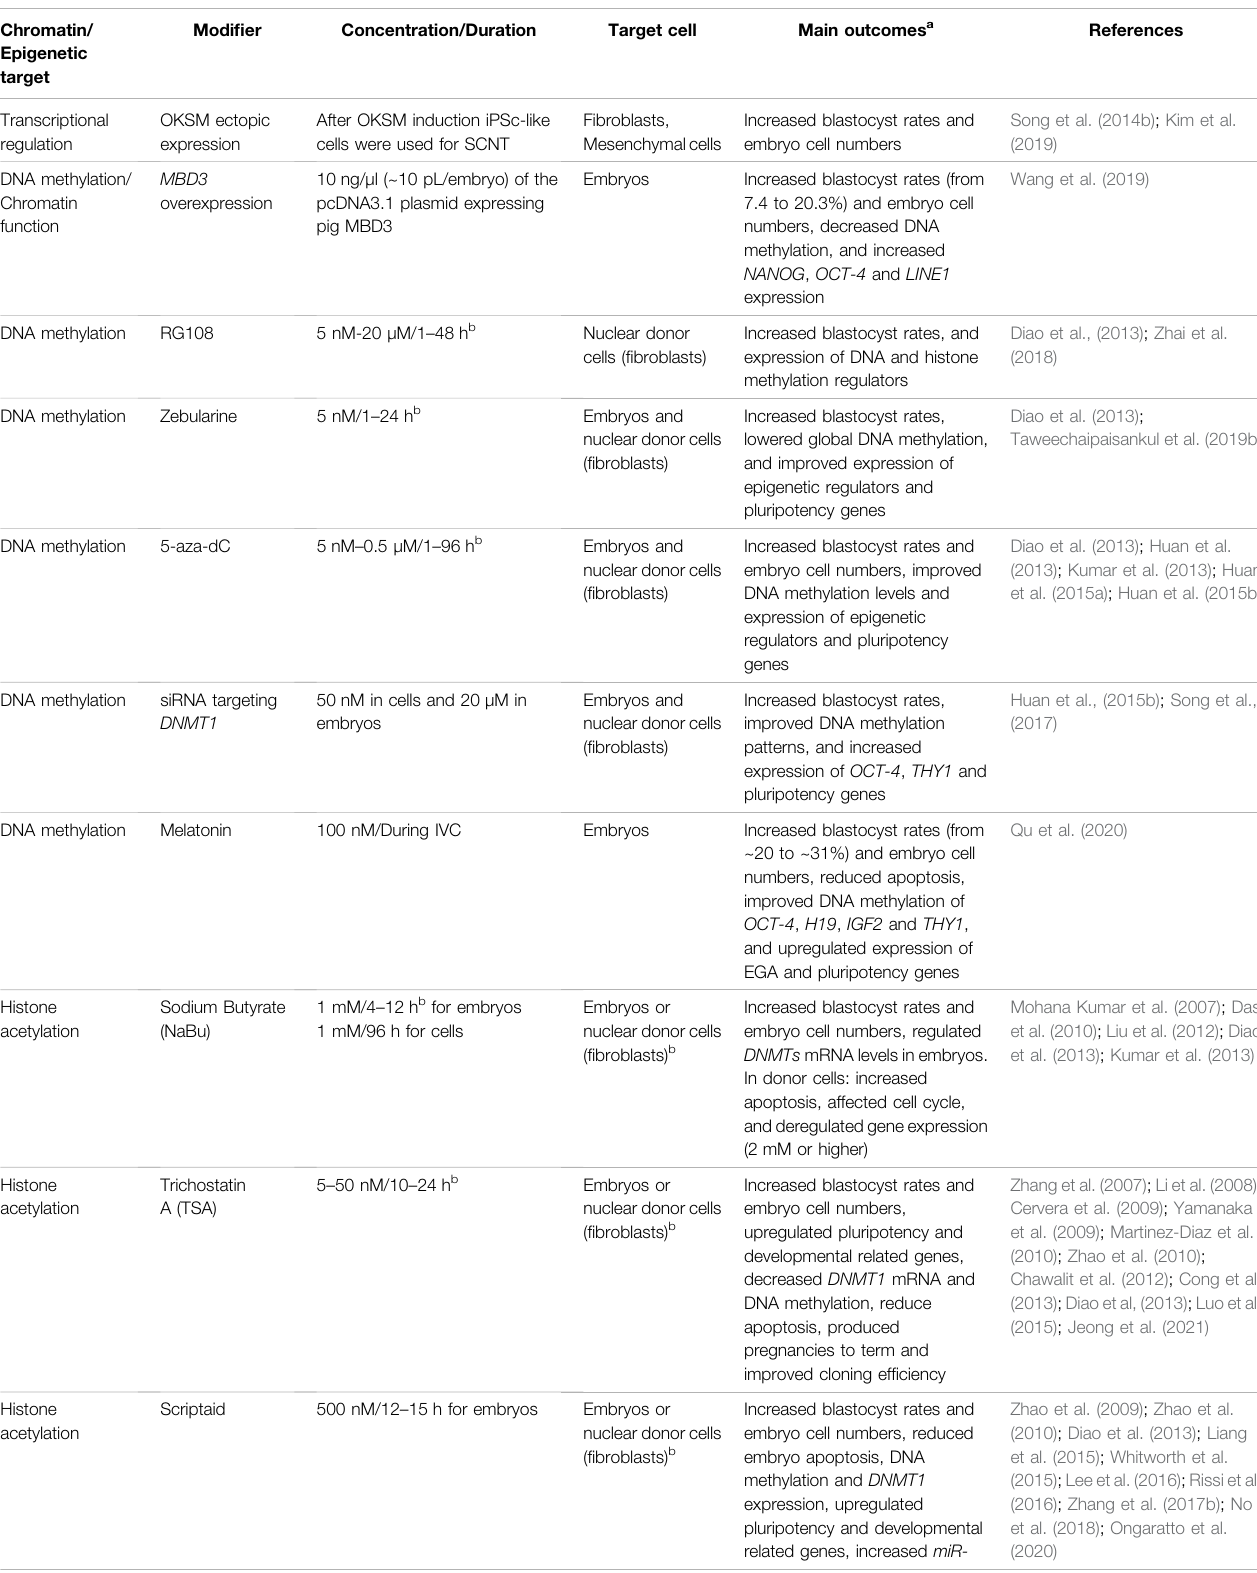
TABLE 1 | Impact of different modi fi ers of chromatin or epigenetic marks on development of SCNT embryos and pig cloning ef fi